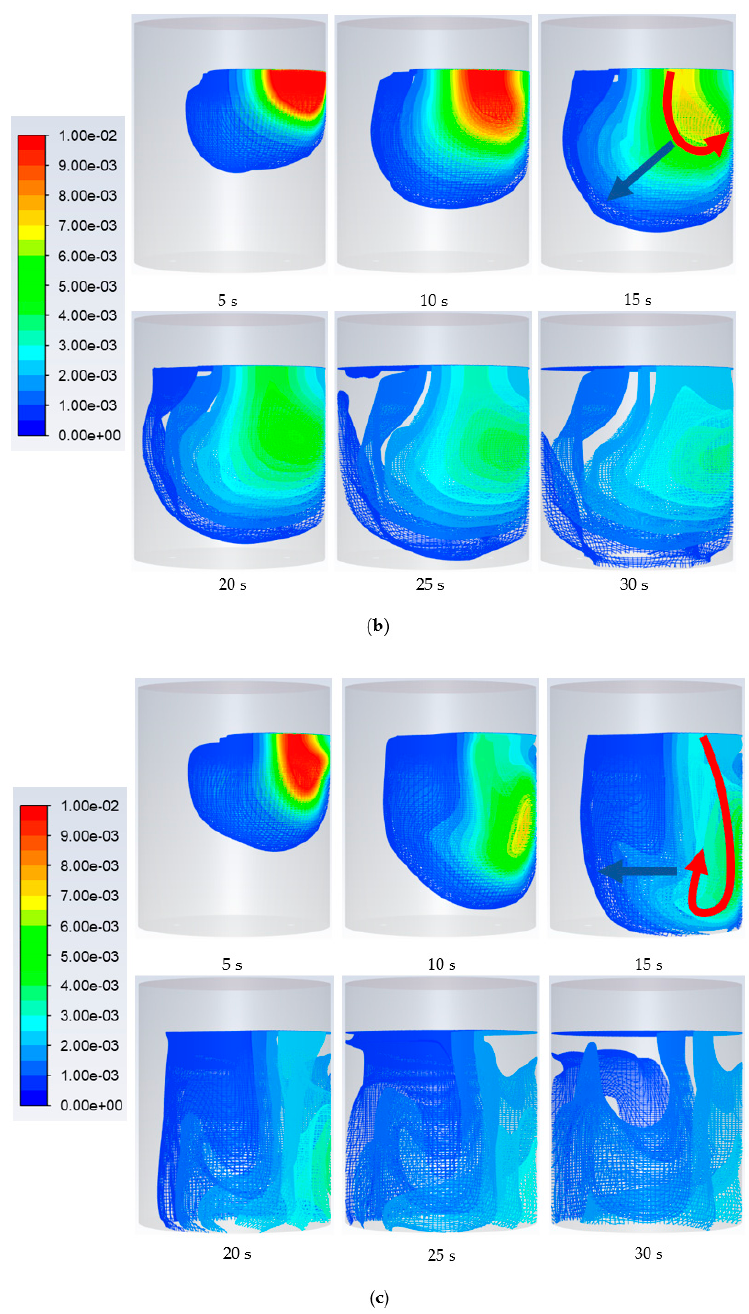
Figure 14. Effect of tracer’s natural convection on the mixing pattern for a low flow rate of 0.98 L ‧ min − 1 : ( a ) color dye experiment; ( b ) modelling with a fixed flow pattern; and ( c ) modelling without a fixed flow pattern.